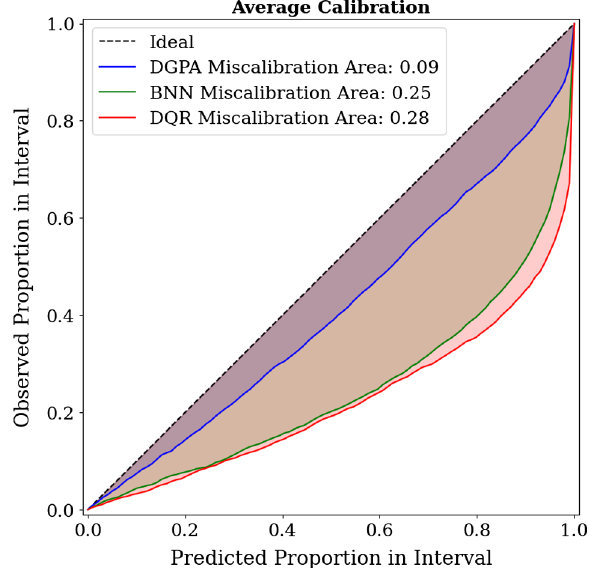
and DQR for OOD data. The shaded area represents the amount of miscalibration in the uncertainty estimation with respect to the true labels.